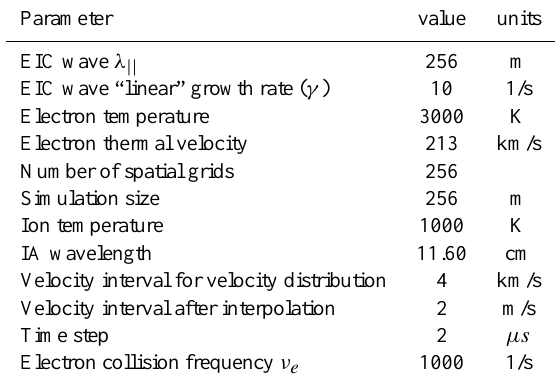
Table 1. Numerical simulation